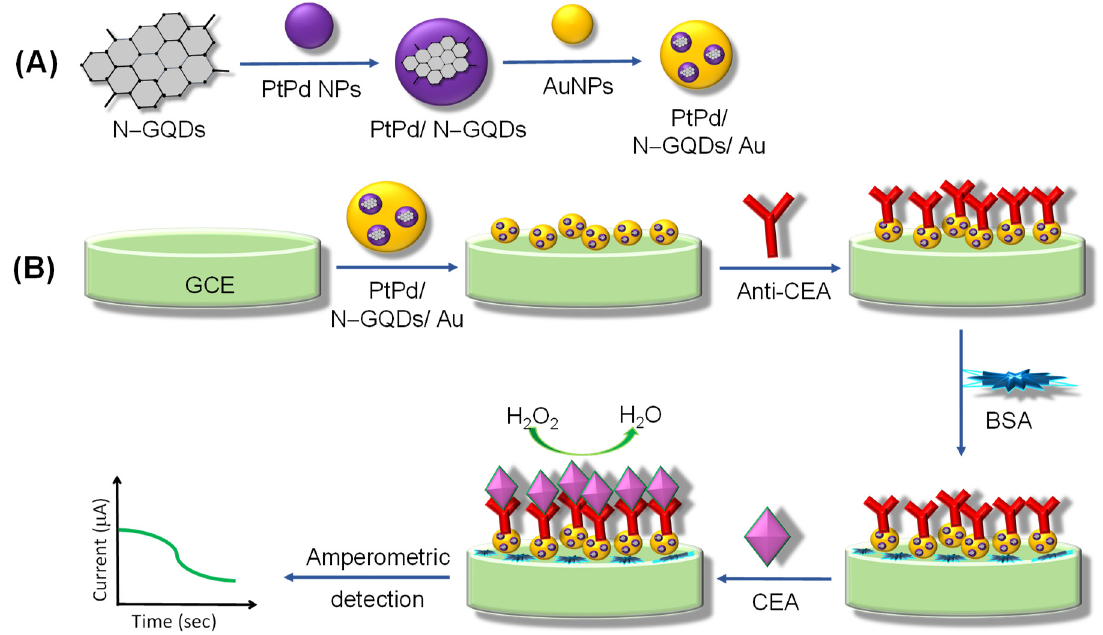
Figure 22. ( A ) Preparatory steps for PtPd/N ‒ GQDs/Au nanohybrid. ( B ) Schematic portrait of a